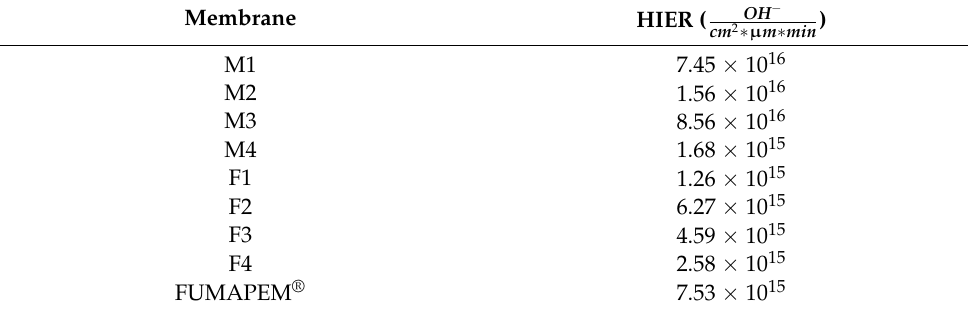
Table 4. Values of hydroxide ion exchange